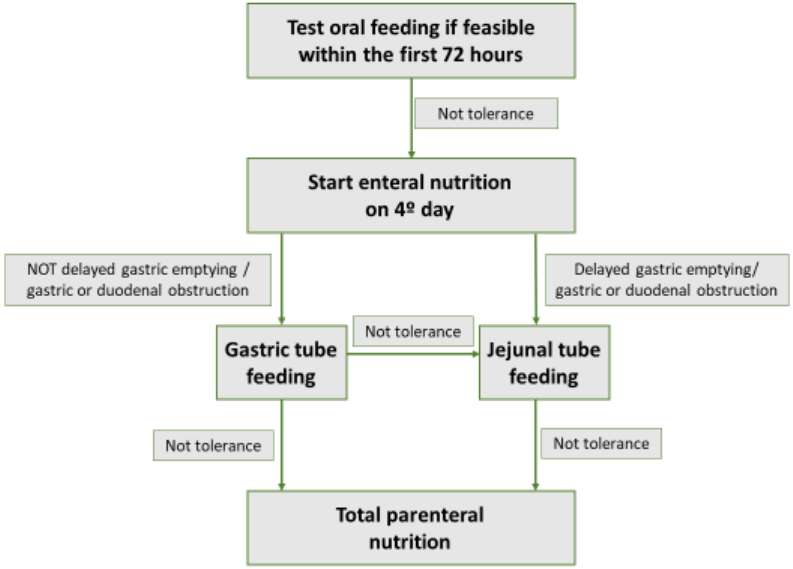
Figure 2. Nutrition algorithm in patients with predicted severe acute pancreatitis.